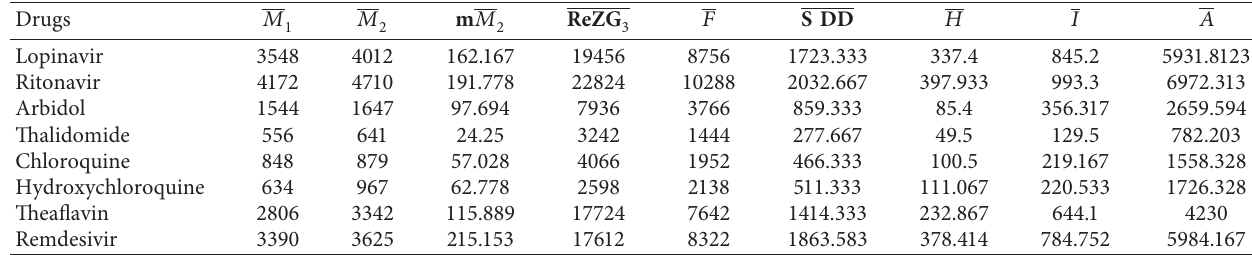
Table 3: The values of topological coindices for molecular graph of COVID-19 Drugs.